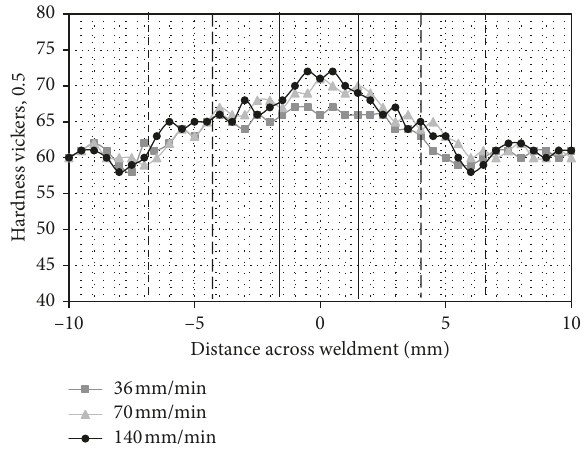
Figure 12: Hardness distribution across weldments welded at different feed rates.